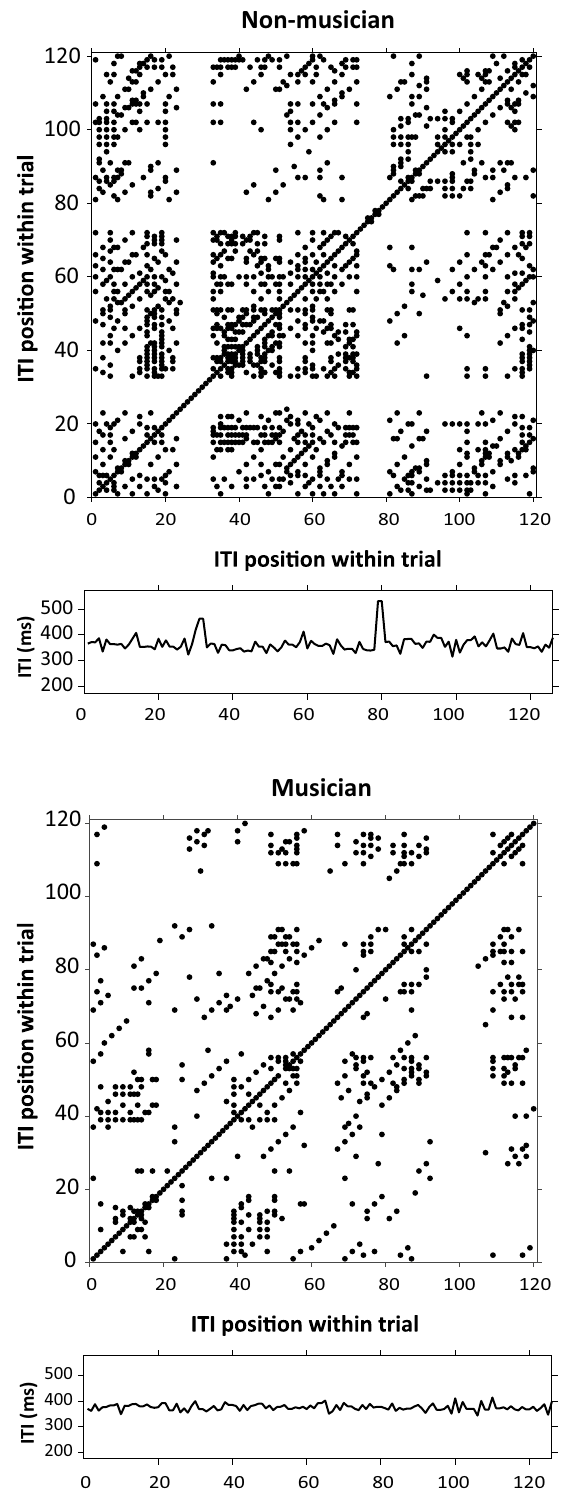
Figure 4. Recurrence plots demonstrating recurrence rate for intertap intervals (ITI) from sample trials of Solo spontaneous production rates. X- and y-axes = ITI time series from sample trial. Top: Non-musician: recurrence rate (represented by proportion of dots) = .0948. Bottom: Musician: recurrence rate =